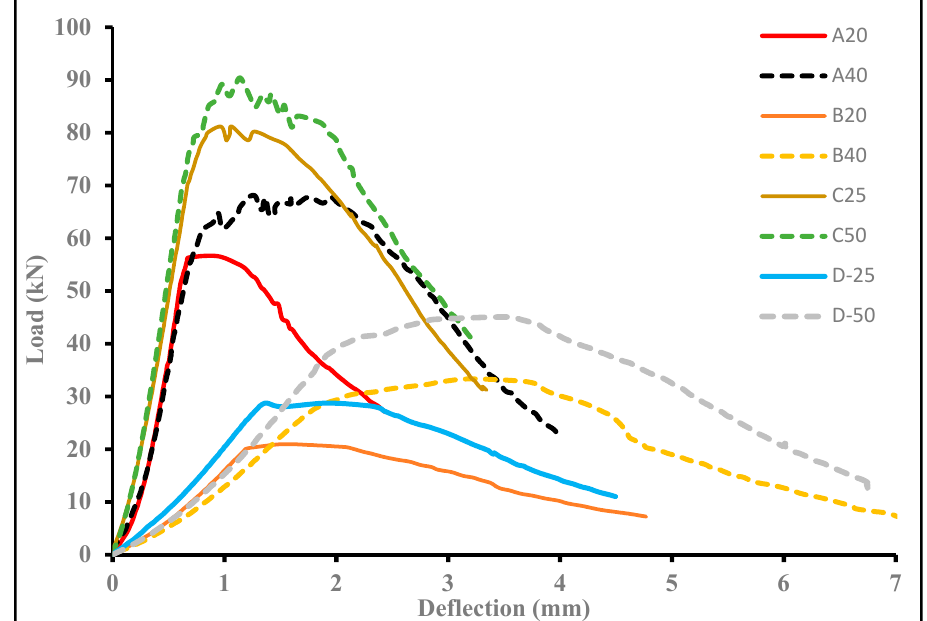
Figure 8. Load–deflection curve for all hybrid beams under flexural loading .